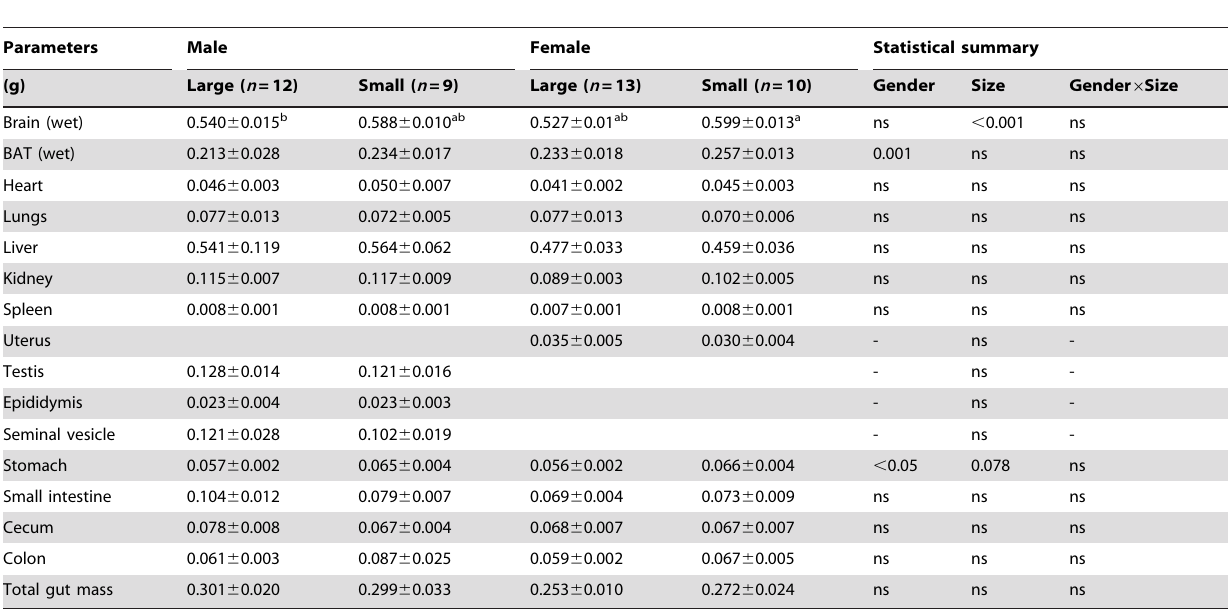
Table 3. Dry mass of organs but brain and BAT (wet mass) in adult male and female offspring from large and small litters.